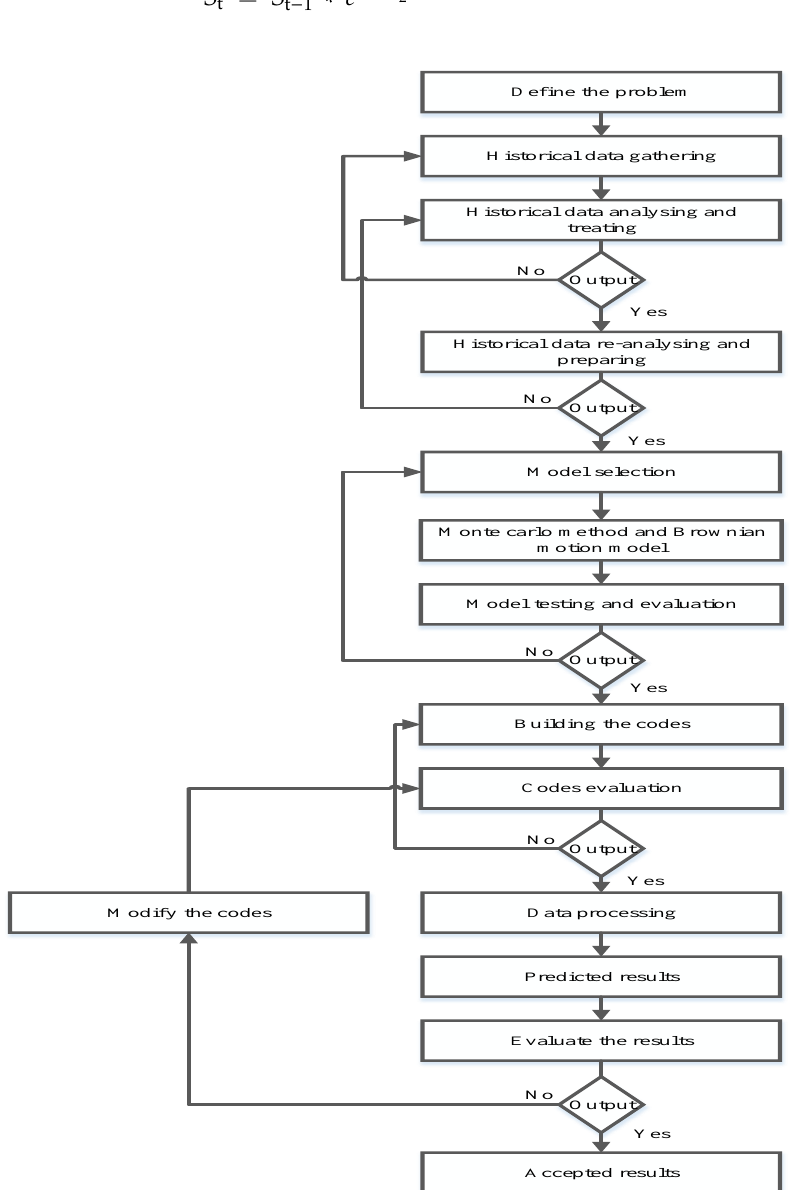
Figure 6. Method processes of historical data gathering, preparing, and building the predictive model.